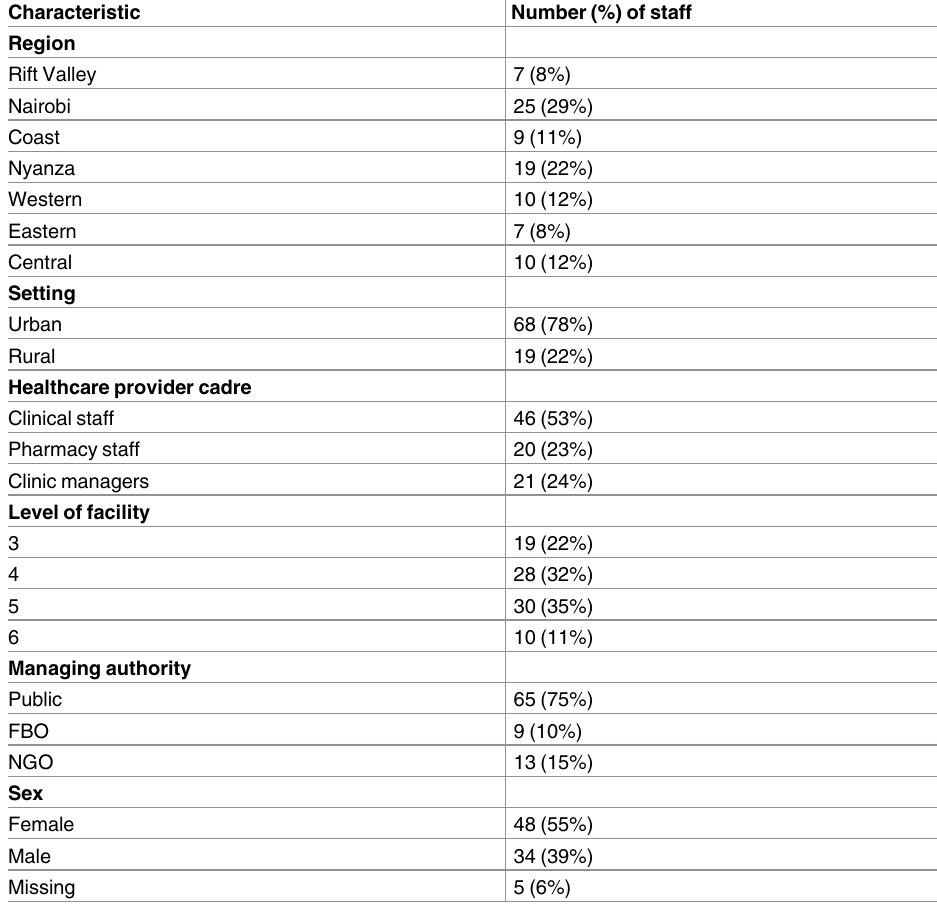
Table 2. Characteristics of healthcare providers interviewed ( n =